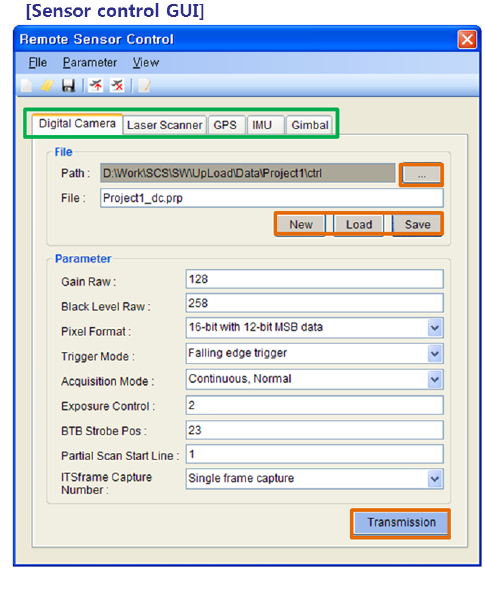
Figure 7. Sensor control subsystem